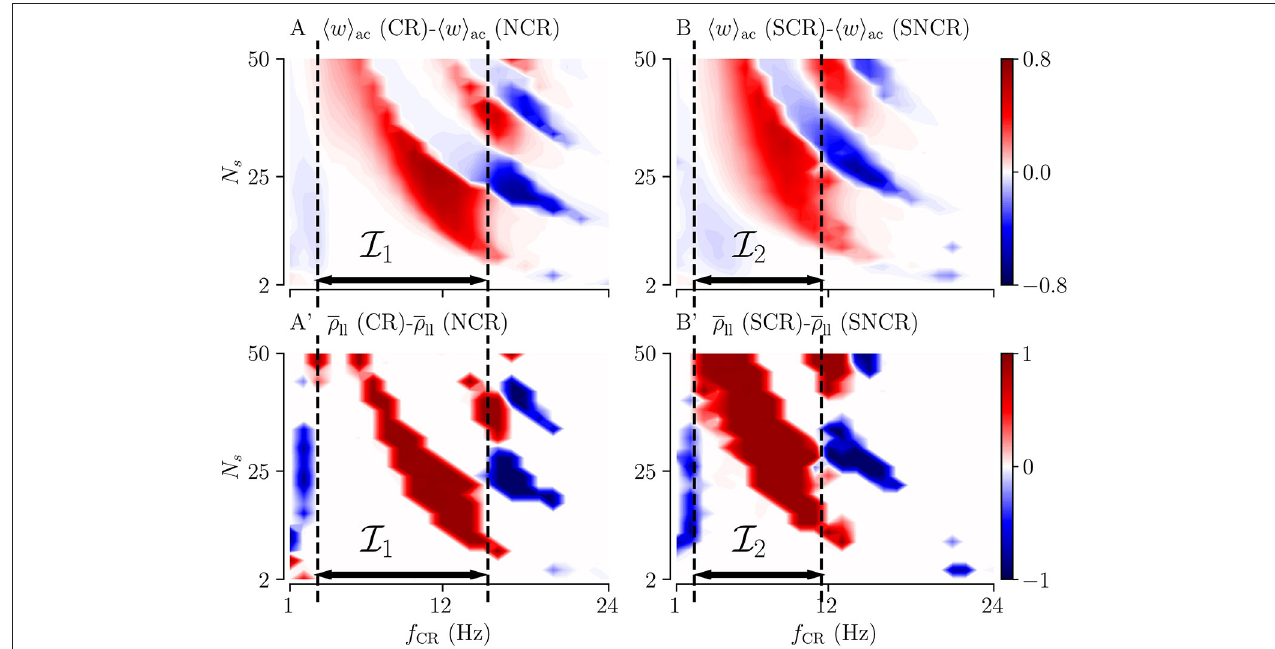
FIGURE 6 | Differences between the outcomes of stimulation with deterministic stimulus onset times (CR/SCR) and NCR/SNCR stimulation with maximum jitter, σ CR = 1. The difference maps for the acute mean weight (A,B) and for the long-lasting Kuramoto order parameter (A’,B’) . Parameter regions where NCR/SNCR led to smaller mean weight/values of the long-lasting Kuramoto order parameter compared to CR/SCR are marked red. Dashed vertical lines enclose the largest continuous range of stimulation frequencies where NCR/SNCR stimulation with maximum jitter led to similar or better outcome than CR/SCR stimulation. These frequency ranges are referred to as I 1 , and I 2 in the text. Data are taken from panels A,E (acute mean weight) and A”’,E”’ (long-lasting Kuramoto order parameters) of Figures 3 , 4 ,